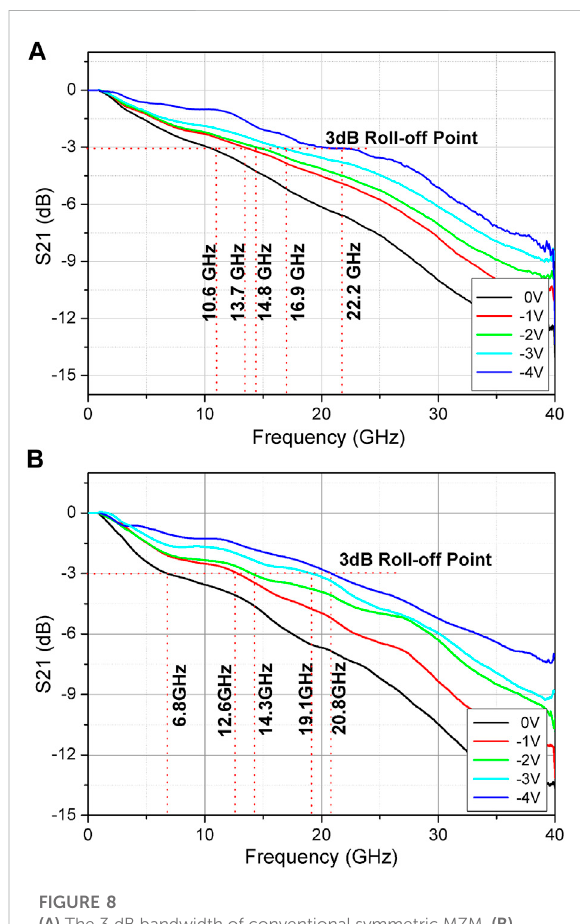
FIGURE 8 (A) The 3 dB bandwidth of conventional symmetric MZM. (B) The 3 dB bandwidth of light-intensity-balanced